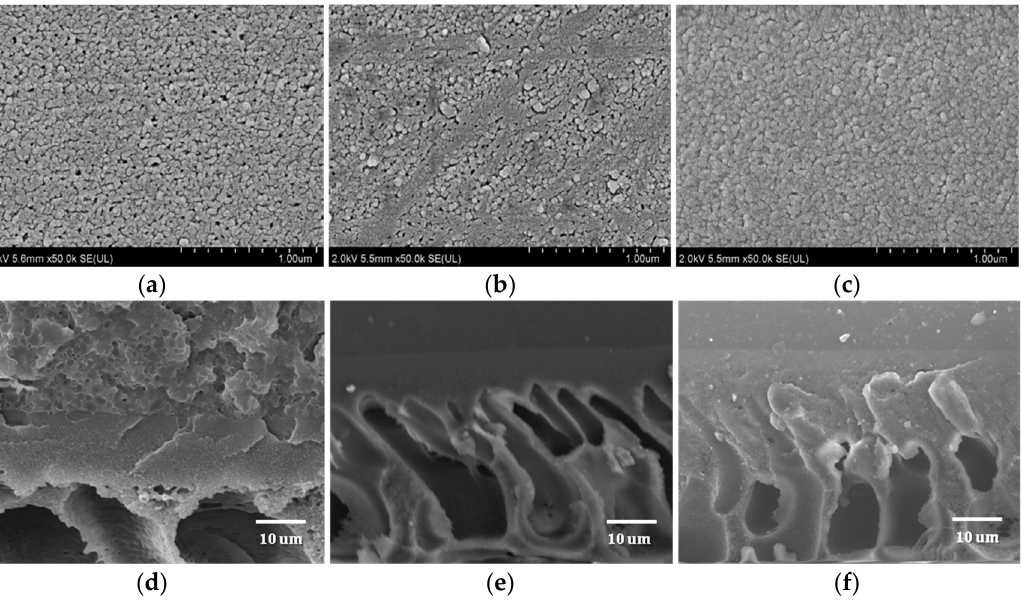
Figure 5. The surface and cross-sectional SEM images of PES ( a , d ), PES/PDA-g-C 3 N 4 ( b , e ), and M5 ( c , f ) membranes.